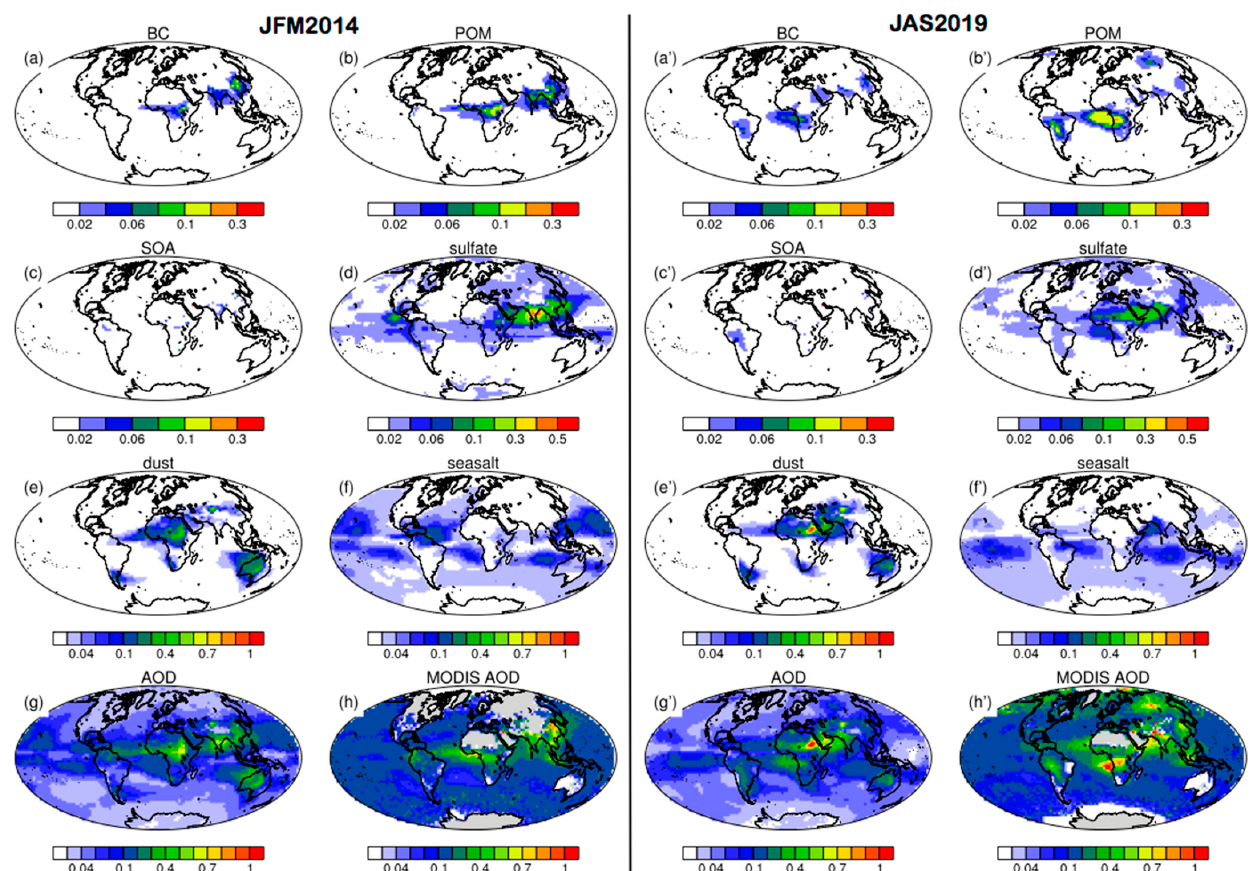
Figure 5. Model evaluation of aerosol optical depth (AOD) at 550 nm for the JFM2014 (left panel) and JAS 2019 (right panel) periods in BAM AMIC experiments. Simulated mean (JFM and JAS) AODs for BC, POM, SOA, sulfate, dust, and sea salt ( a – f ; a’ – f’ ). Total AOD ( g , g’ ) is compared with MODIS observations ( h , h ’) for respective periods.